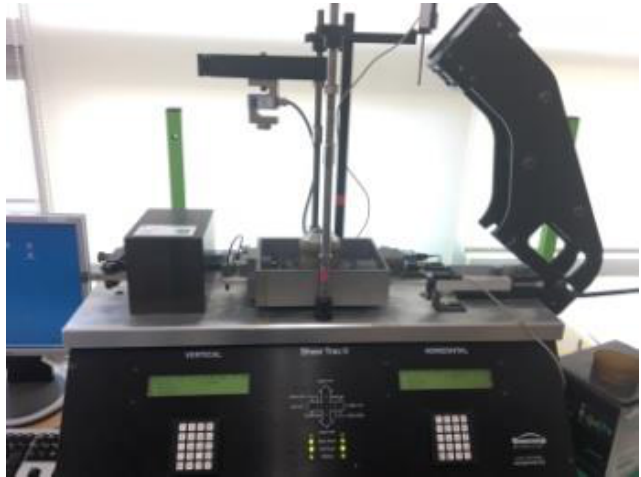
Figure 4. Direct simple shear apparatus.